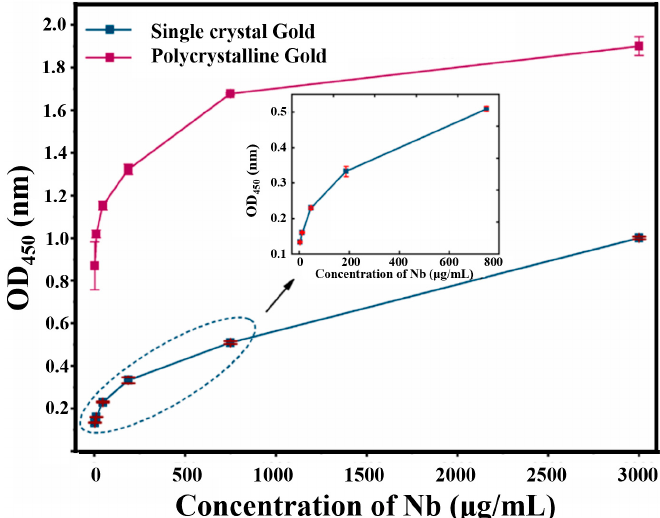
Figure 5. Comparison of the amount of Nbs modification of the polycrystalline and single-crystal electrode. Six different concentrations of AR-H2-1 were immobilized with the two types of electrode. The red line represents the polycrystalline electrode; the blue line represents the single-crystal electrode. The optical density (OD 450 ) values of the polycrystalline electrode were higher than those of the single-crystal.